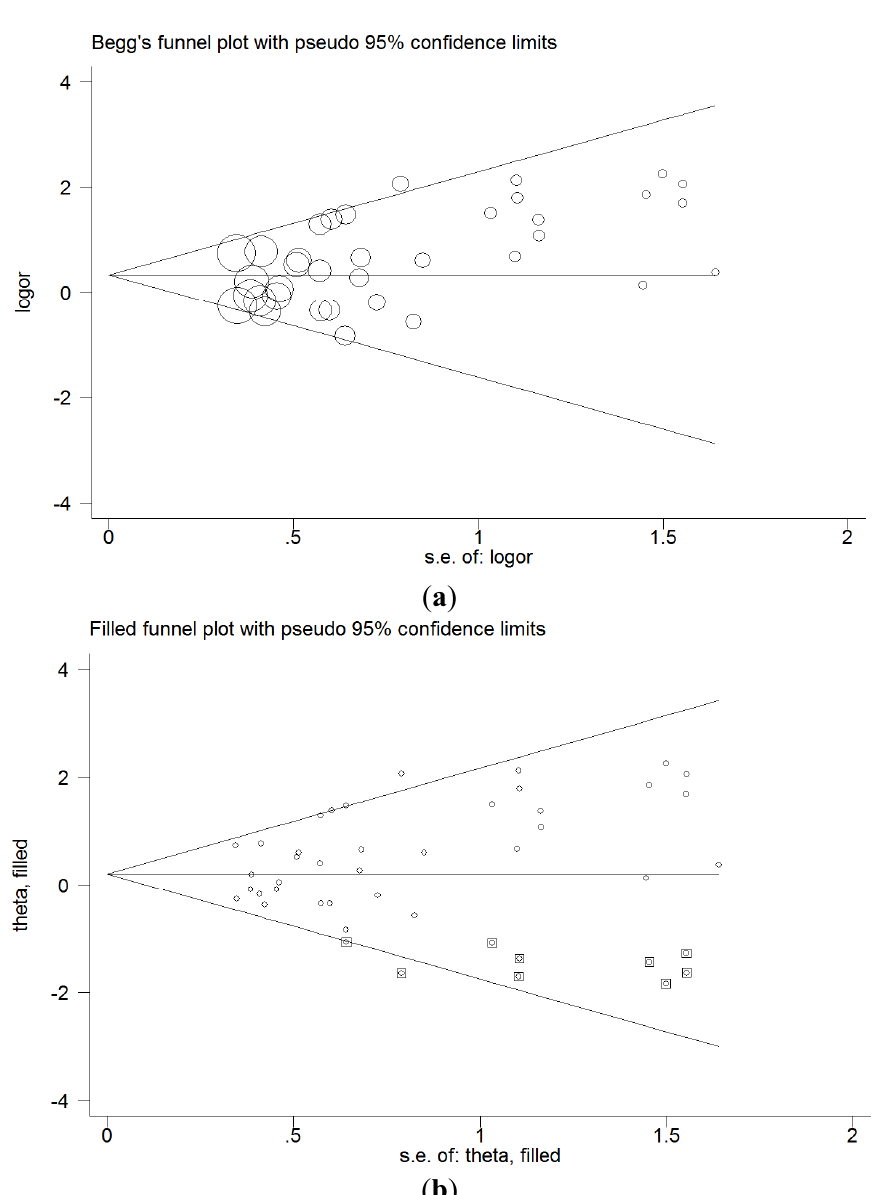
Figure 3. Begg’s funnel plot of publication bias test (homozygote comparison). ( a ) Before trim and fill method; and ( b ) After trim and fill